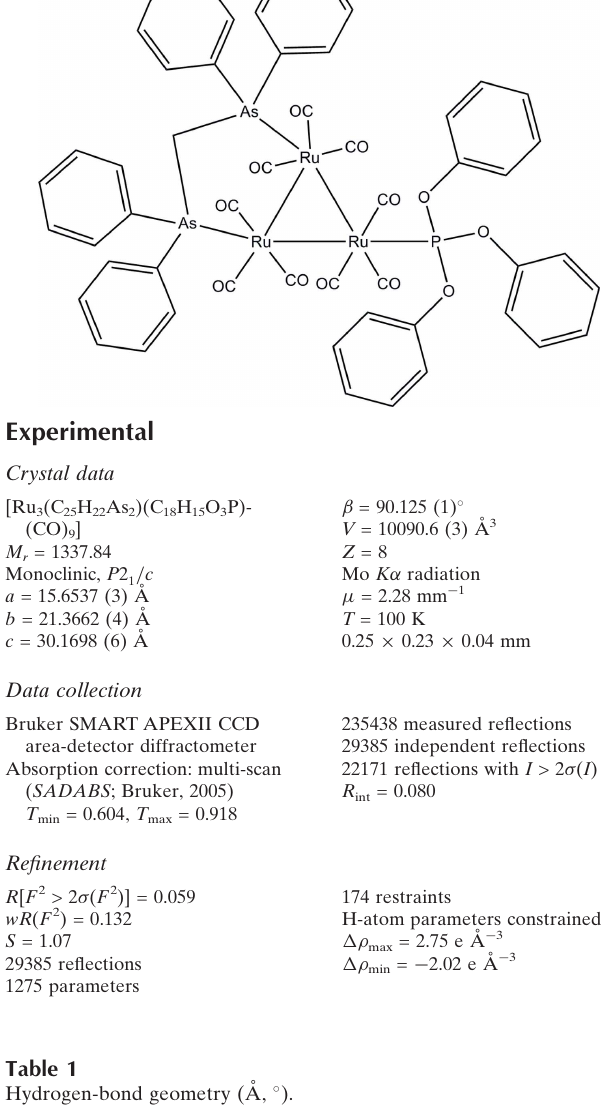
Hydrogen-bond geometry (A ˚ , (cid:3)